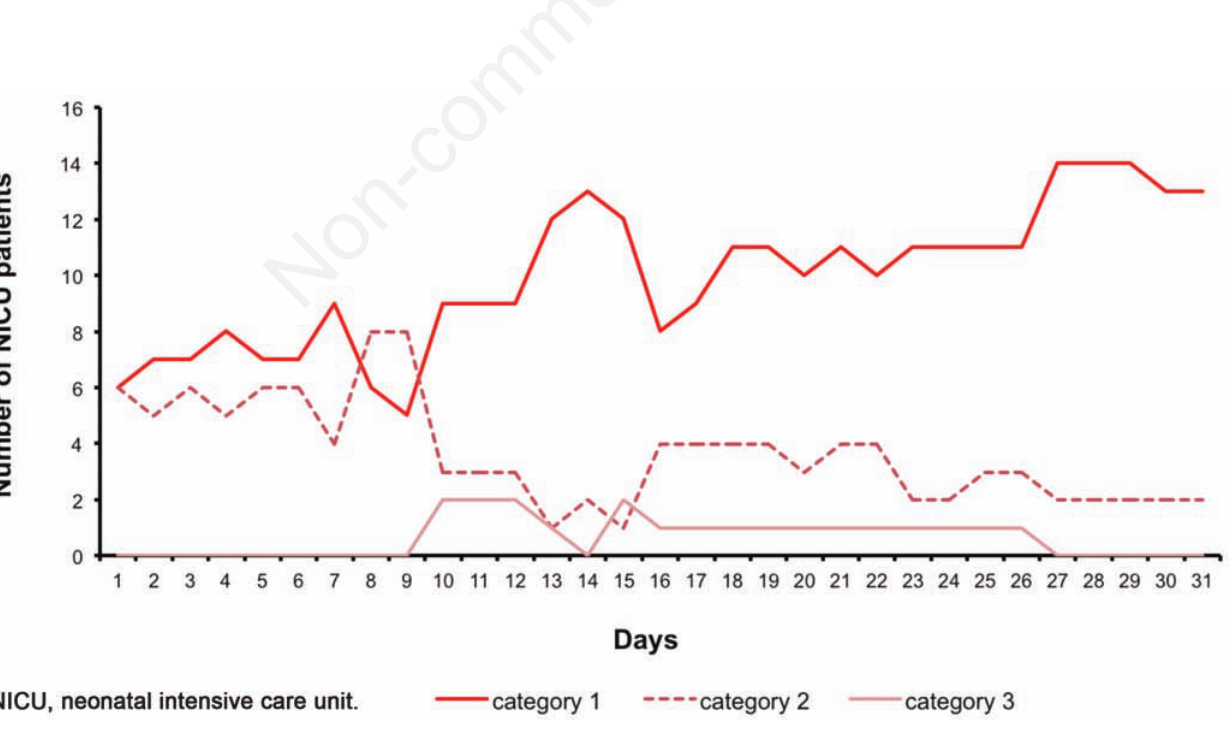
Figure 1. Total number of neonatal patients in British Association of Perinatal Medicine (BAPM) category of care 1 to 3 per day. There were no patients in category 4 during the time of data